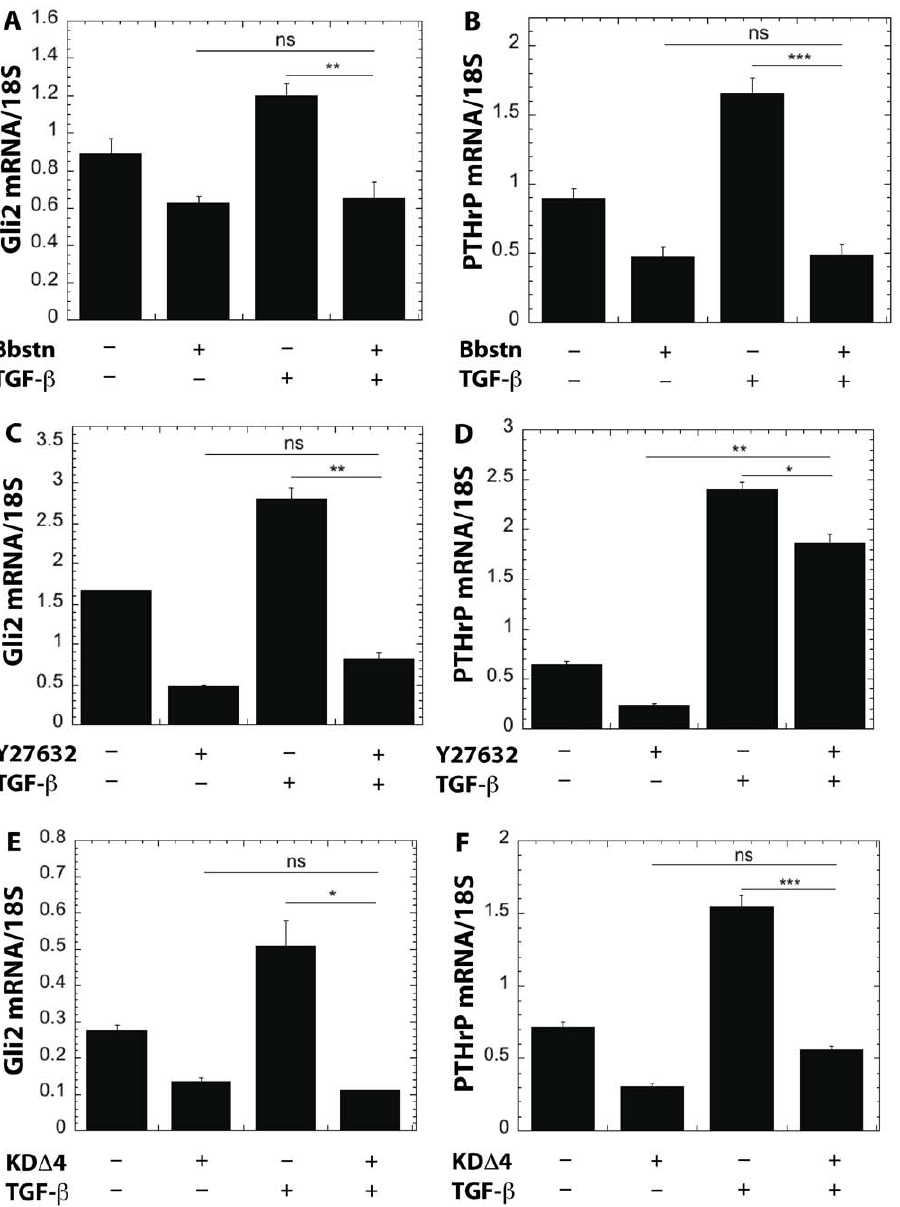
Figure 6. Inhibition of mechanotransduction and ROCK suppresses PTHrP expression induced by exogenous TGF-ß. Treatment with blebbistatin inhibits expression of (A) Gli2 and (B) PTHrP by MDA-MB-231 cells cultured on TCPS. Treatment with 5 ng/ml exogenous TGF-ß increases PTHrP and Gli2 expression, and treatment with both TGF-ß and blebbistatin reduces expression to levels observed for blebbistatin alone. Similarly, treatment of MDA-MB-231 cells with the ROCK inhibitor Y-27632 inhibits (C) Gli2 and (D) PTHrP expression. In the presence of both exogenous TGF-ß and Y-27632, both PTHrP and Gli2 expression are significantly reduced, but PTHrP expression is only partially inhibited relative to treatment with Y- 27632 alone. Expression of (E) Gli2 and (F) PTHrP in MDA-MB-231 cells genetically modified to express a dominant negative form of ROCK (MDA-MB- 231 KD D 4) is significantly lower than that measured for plasmid control MDA-MB-231 cells. Treatment with exogenous TGF-ß does not significantly increase Gli2 or PTHrP expression in KD D 4 cells. *, # =p , 0.05; **, ## =p , 0.01; ***, ### =p ,